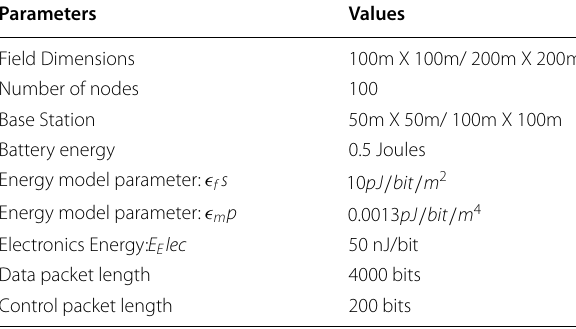
Table 1 Initial parameter for network Parameters